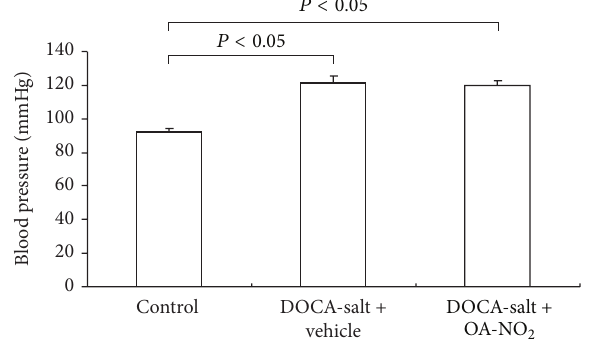
Figure 2: The changes of blood pressure in control ( 𝑛 = 5 ), DOCA- salt + vehicle ( 𝑛 = 8 ), and DOCA-salt + OA-NO 2 ( 𝑛 = 8 ) mice after 3 weeks of DOCA-salt treatment. Data are shown as mean + SE.